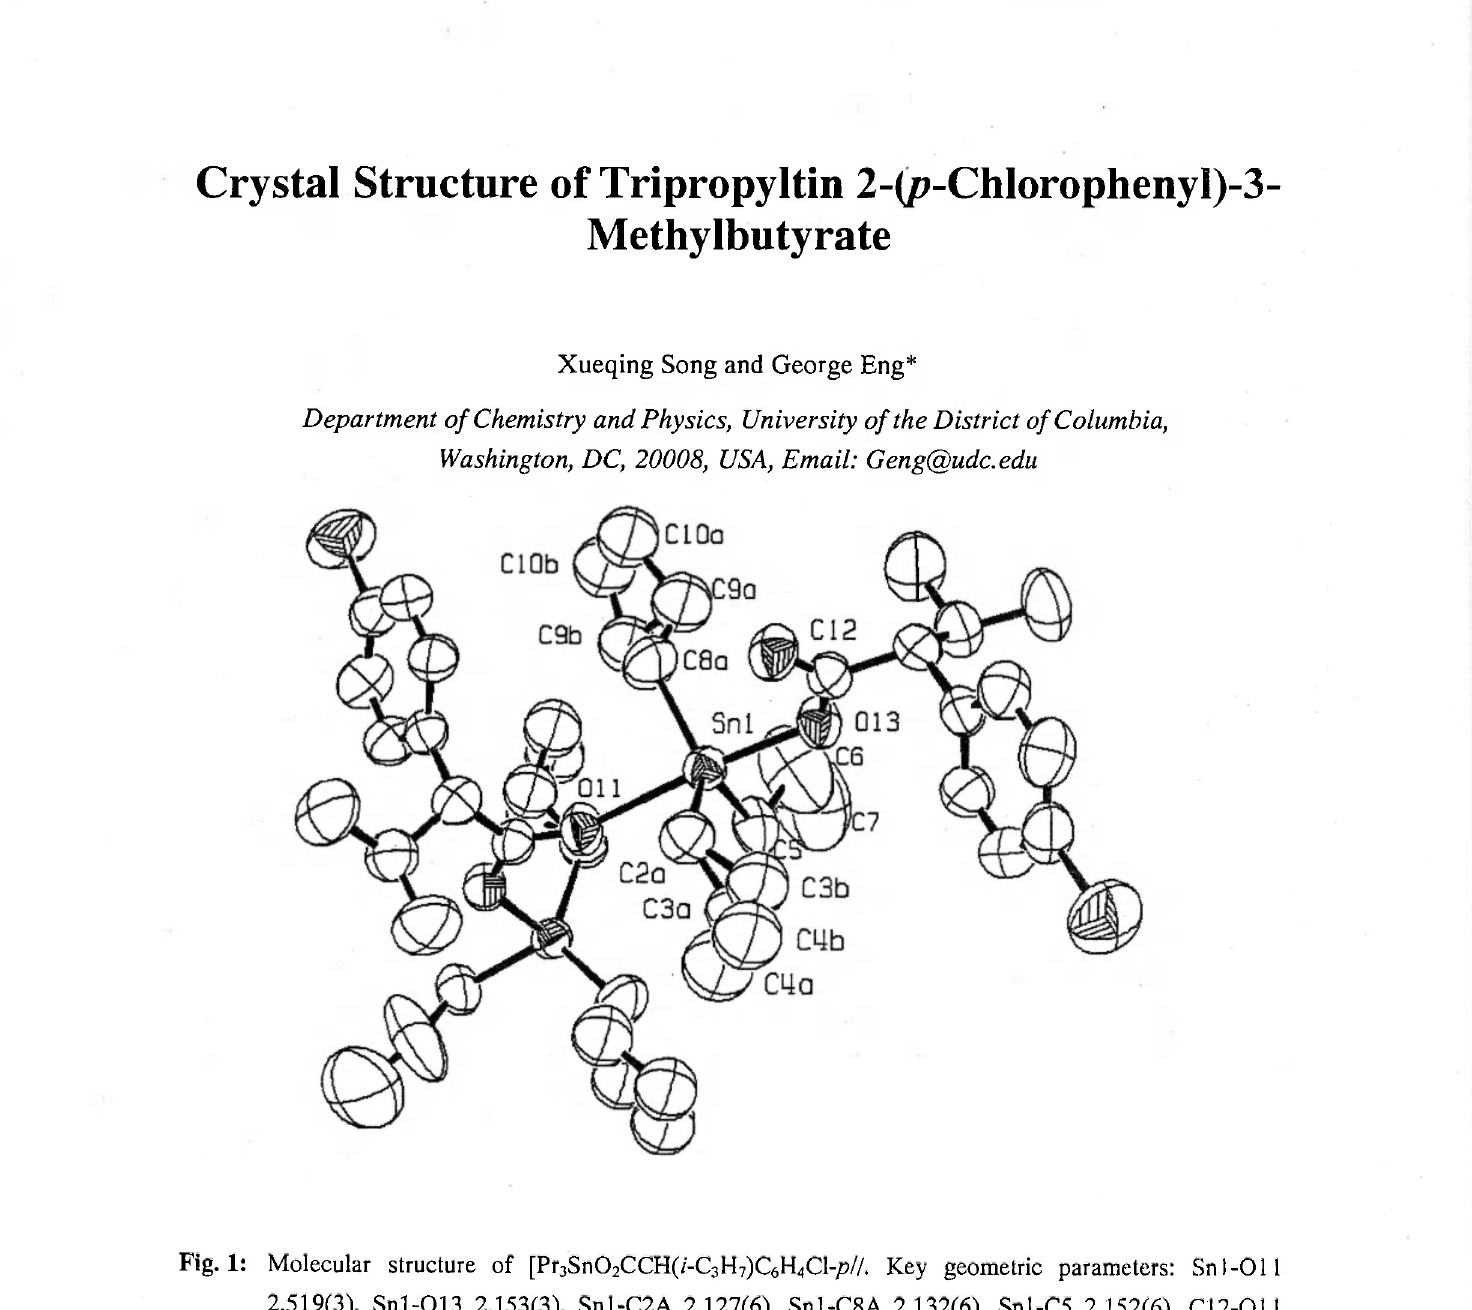
Fig. 1: Molecular structure of [Pr 3 Sn0 2 CCH(/-C 3 H 7 )QH 4 Cl-p//. Key geometric parameters: Sn 1-011 2.519(3), Snl-013 2.153(3), Snl-C2A 2.127(6), Snl-C8A 2.132(6), Snl-C5 2.152(6),